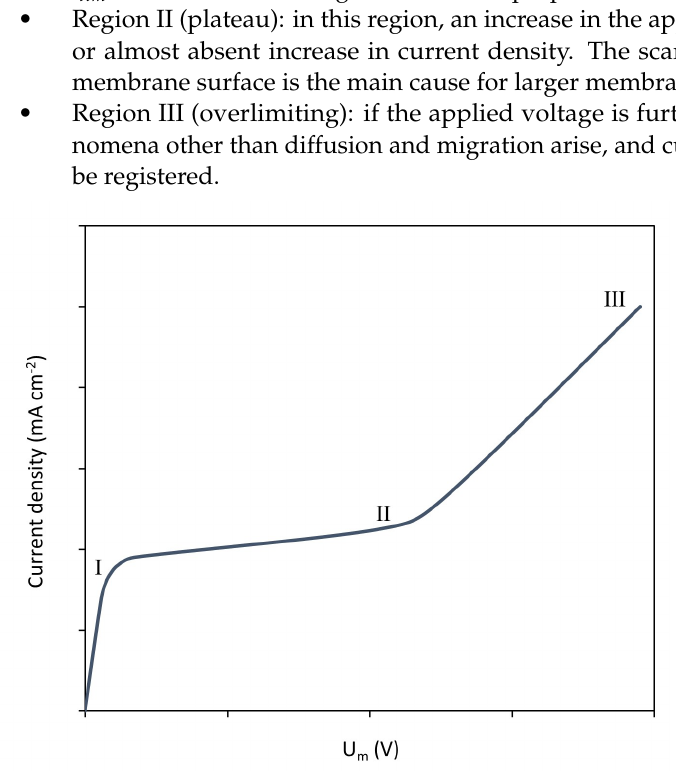
Figure 1. Typical current–voltage curve of a monopolar ion-exchange